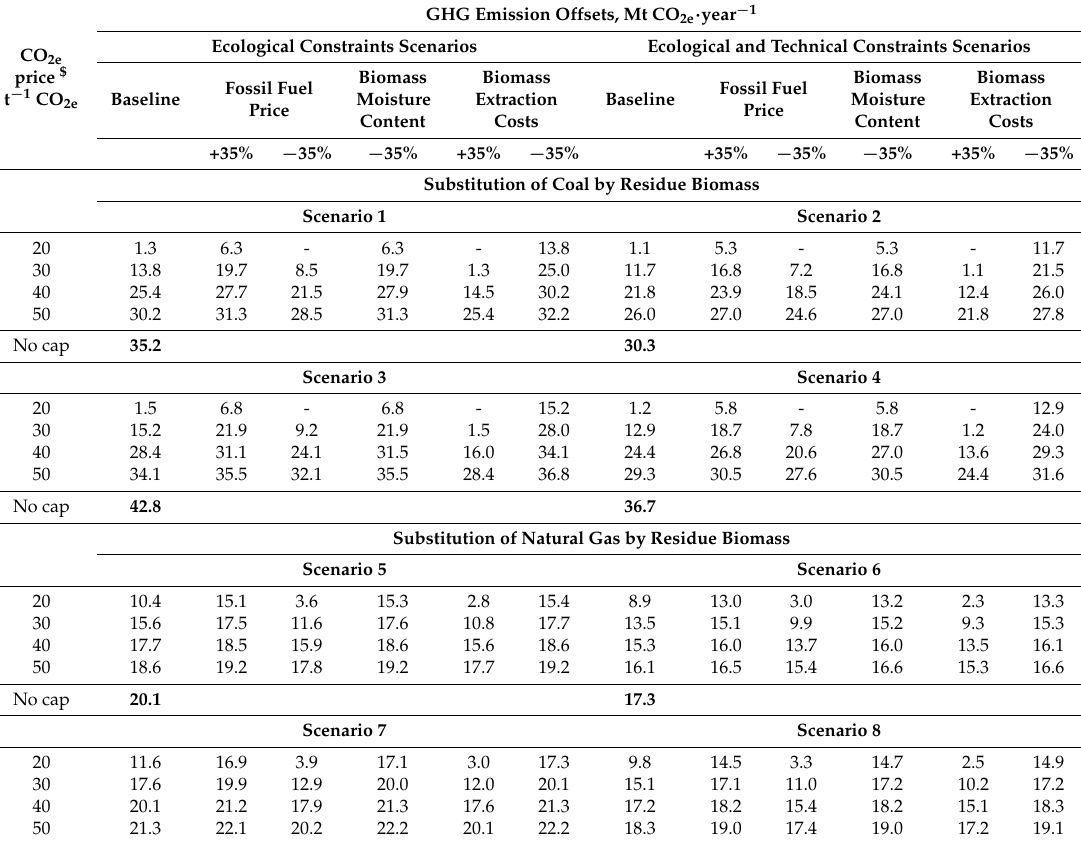
Table 2. Nationwide estimates of greenhouse gas (GHG) emission offsets at different offset price levels by scenario *, using baseline parameter values and altered parameters for sensitivity